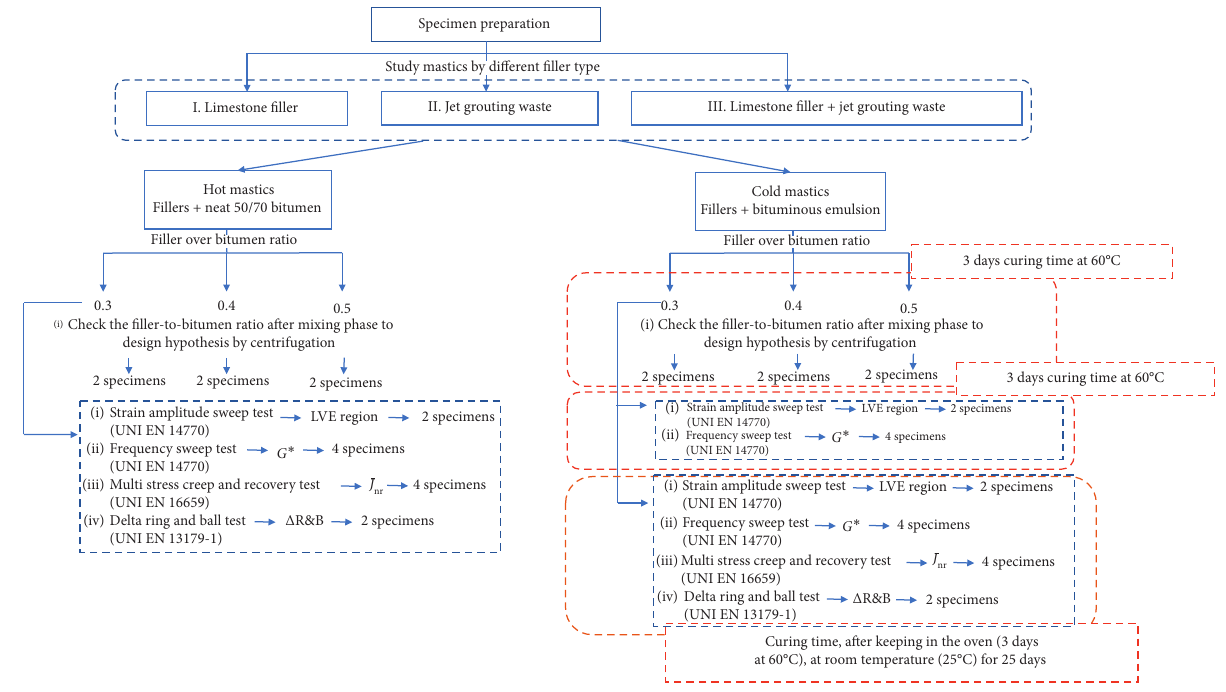
Figure 1: Flowchart for the mixed specimens in laboratory investigations. Table 1: Main properties of materials: (a) chemical composition of JW filler, and (b) JW and LF specific gravity and Rigden